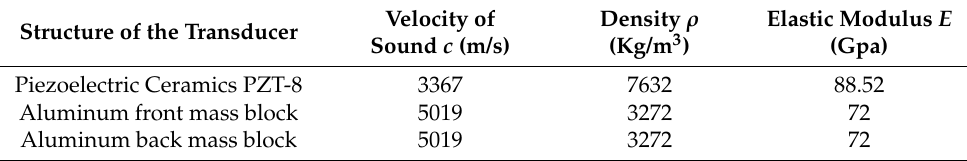
Velocity of Density ρ Elastic Modulus E Sound c (m/s) (Kg/m 3 ) (Gpa)